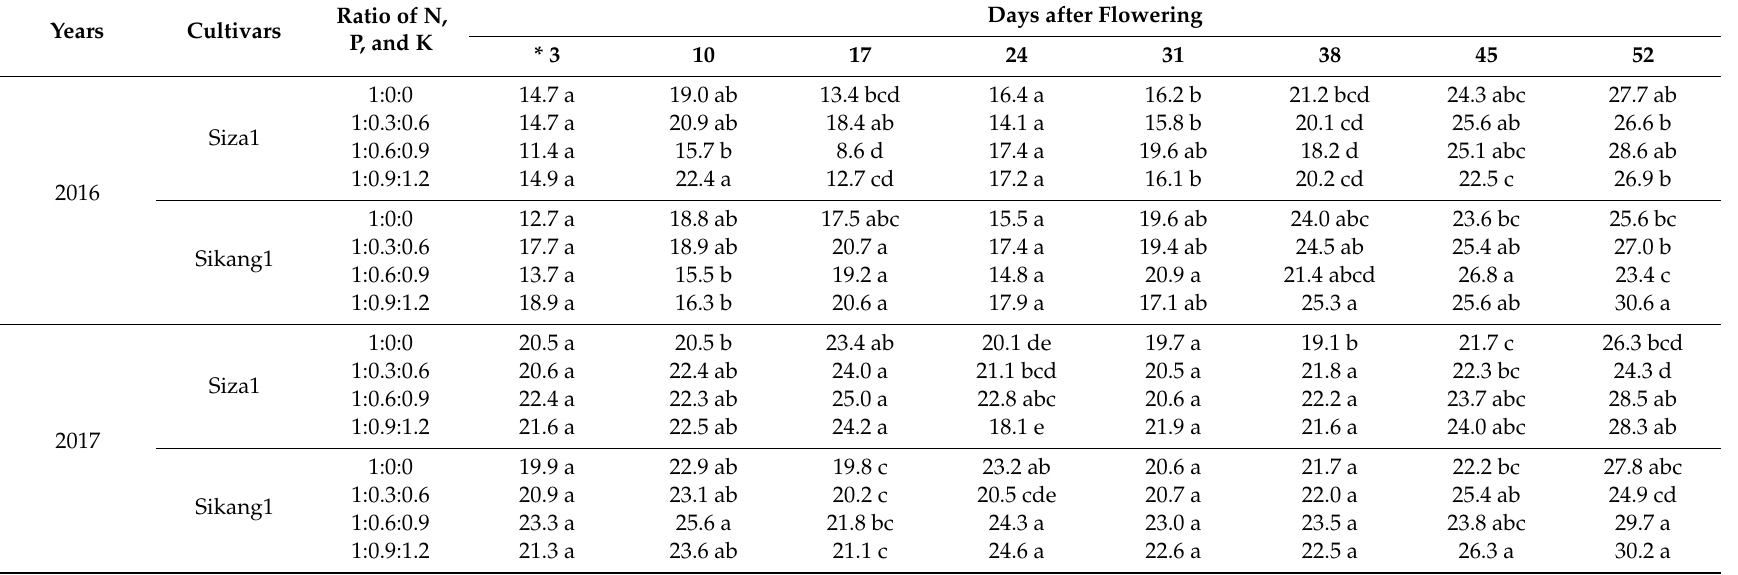
Table 3. E ff ects of the ratio of nitrogen, phosphorous, and potassium application on cotton fresh boll weight (g) of Siza 1 and Sikang 1 during 2016 and 2017. Years Cultivars